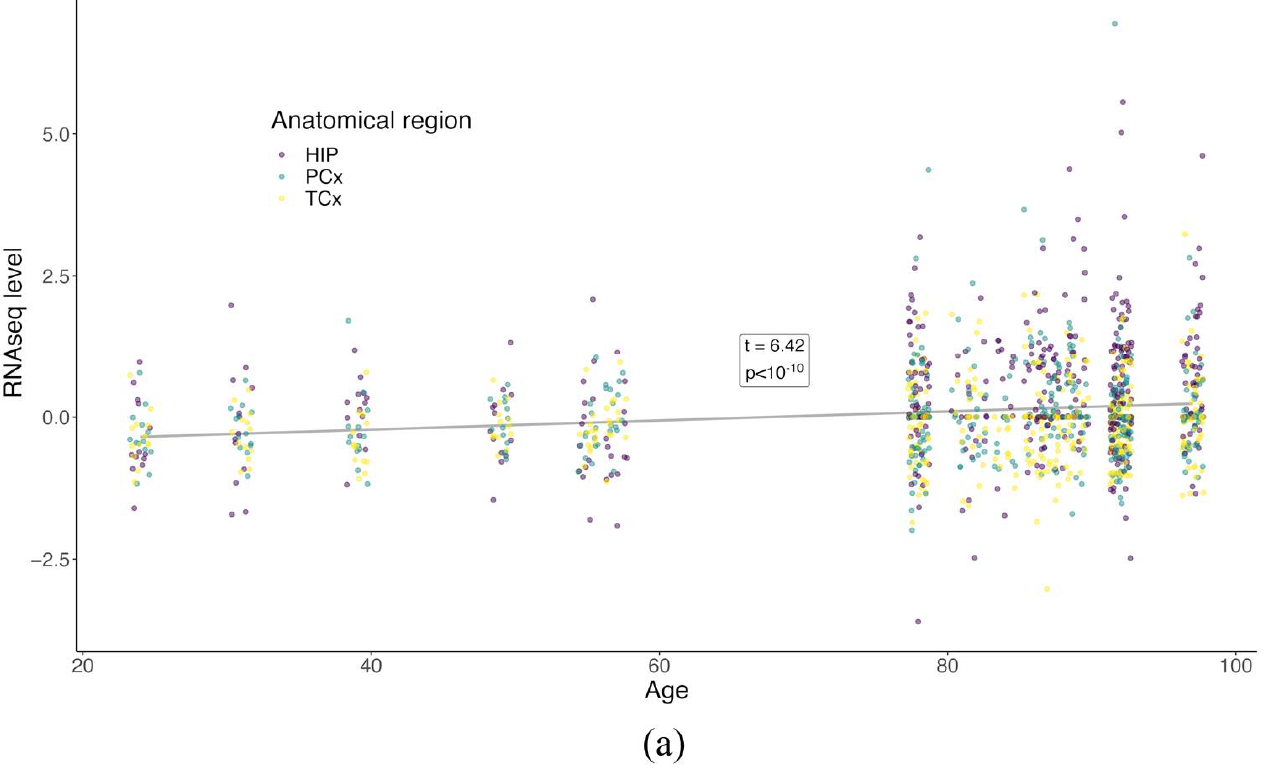
Figure 1. AQP expression profiles show region-specific changes with age in healthy human brains. ( a ) Mixed-effect linear plot testing the relationship between all AQP RNAseq levels and age in the HIP (purple), PCx (green) and TCx (yellow) brain regions. Each point represents the RNAseq level determined for a given gene in a single subject for the selected brain region: HIP (purple), PCx (green) and TCx (yellow). t -values represent the test statistic associated with the comparison of the two means using two-sample t -tests, with positive values indicating a larger average RNAseq. ( b ) Linear regression plots of individual AQP channels and RNAseq levels as a function of age separated by anatomical areas with a significance change in trends are shown, respectively, as *** for p < 0.001 and * for p < 0.05. The p values for regressions that had significant non-zero slopes are listed as inset text boxes within each figure panel. 3.3. AQP Expression Profiles in the Hippocampus Differ from Those in Cortex in Healthy Brain A clear distinction in expression profiles was observed between the HIP cluster and the PCx and TCx clusters, with no difference between cortical regions observed when comparing probes of AQP channel genes within each anatomical region (Figure 2) . Two principal components (Figure 2a, component 1 and component 2) were evaluated as a function of all probes used (Supplementary Table S2). The distinction between the